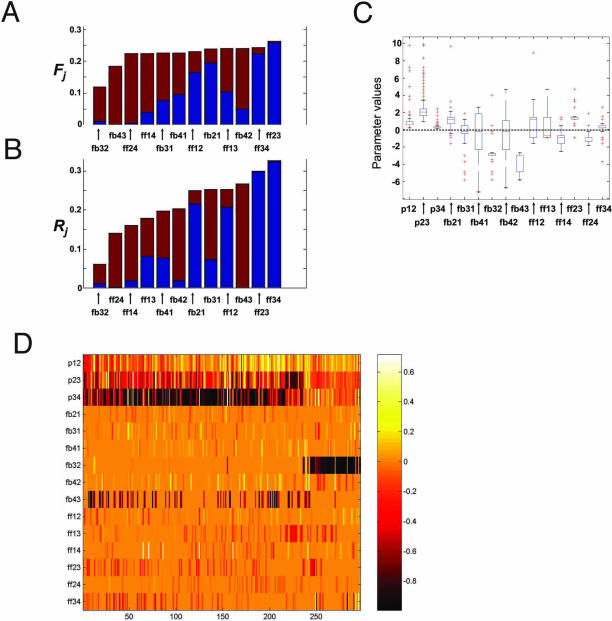
The Possible Feedforward and Feedback Interactions between Developmental States Are Analyzed by Applying Fitness, Robustness, Consistency, and Control Criteria(A) All possible feedforward and feedback interactions are rank-ordered according to whether they are mostly present in the models of higher fit to the data in Figure 2A. Specifically, the fitness metric Fj is calculated for each interaction j by summing the inverse values of vM, determined as described in Figure 2C, over all models M where the interaction j is present. The models are then ranked according to the values of Fj.(B) All possible feedforward and feedback interactions are rank-ordered according to whether they are mostly present in the models of higher robustness. Specifically, the robustness to parameter variation metric Rj is calculated for each interaction j by summing the inverse values of fM , determined as described in Figure 2C, over all models M where the interaction j is present. The models are then ranked according to the values of Rj.(C) The consistency of parameter values corresponding to particular feedforward and feedback interactions is evaluated by plotting the parameter values for each model M in which the corresponding interaction is present. Each box has lines at the lower quartile (blue), median (red), and upper quartile (blue) values. The whiskers show the extent of the rest of the data. Outliers (red plus signs beyond the ends of the whiskers) indicate data with values more than 1.5 times the interquartile range away from the top or bottom of the box.(D) A correlation matrix relating the control exercised by each feedback or feedforward interaction in each model in which it is present. Each row in the matrix corresponds to a single parameter, describing a single type of interaction. Each column represents one specific model topology. Models are arranged from left to right in descending order of their best fit to the experimental dataset. The color bar indicates the value of the control metric, defined as the correlation coefficient between the parameter values and their associated SSR values, obtained during the multivariate analysis illustrated in Figure 2C. Note that for ff23, ff34, and fb43 interactions, there is clustering of high negative correlation values for high-ranked models, suggesting the importance of these interactions in influencing the fitness of the high-ranked models.